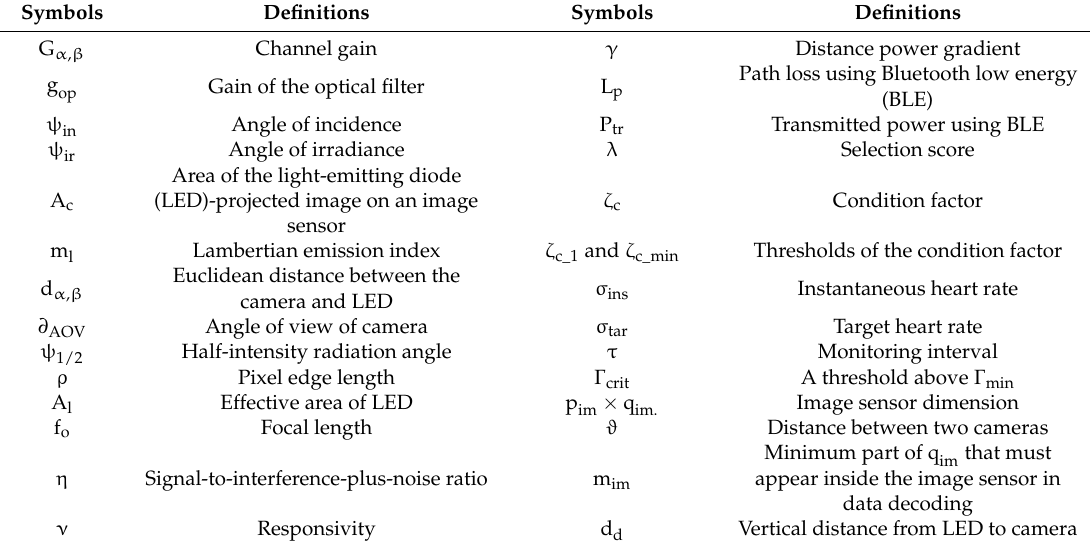
Table 1. List of